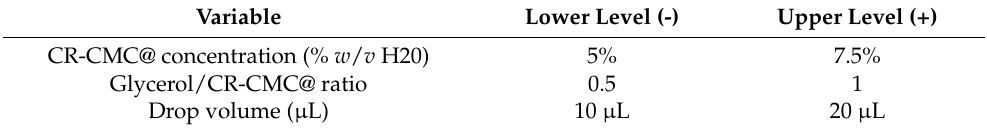
Table 1. Levels definition for CR-CMC@ concentration, glycerol/CR-CMC@ ratio and drop